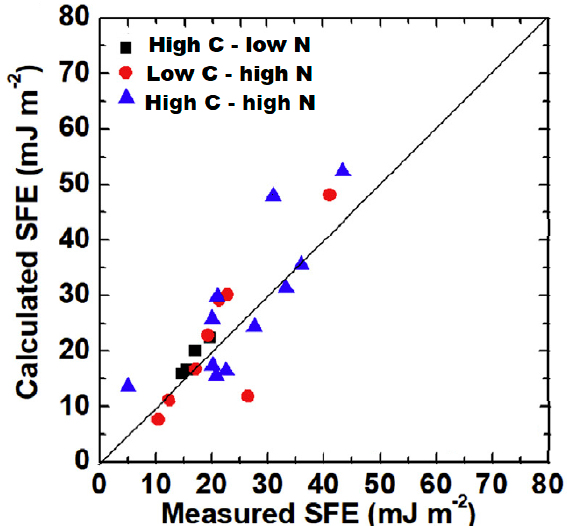
Figure 13. Relationship between thermodynamically-calculated SFE and experimentally measured SFE in Fe-Cr-Mn-C-N steels using most suitable thermodynamic parameters (see ref for thermo- dynamic parameters) [67].